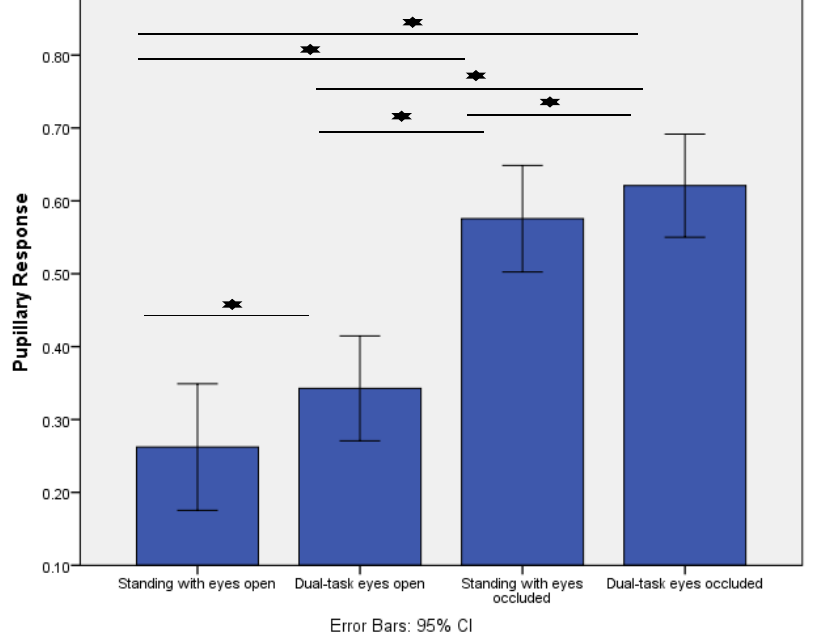
Figure 2. Comparisons of the pupillary response (Index of Cognitive Activity, scale range 0–1) across the four different standing conditions. * indicates p < 0.01. Similarly, posterior alpha power showed a significant condition effect ( p = 0.001). Post-hoc analysis demonstrated that posterior alpha power significantly increased from standing with eyes open (control condition) to standing with eyes occluded ( p = 0.005) and dual-task eyes occluded ( p = 0.009). Moreover, there was a significant increase from dual- task eyes open to dual-task eyes occluded ( p = 0.007) (Figure 3).